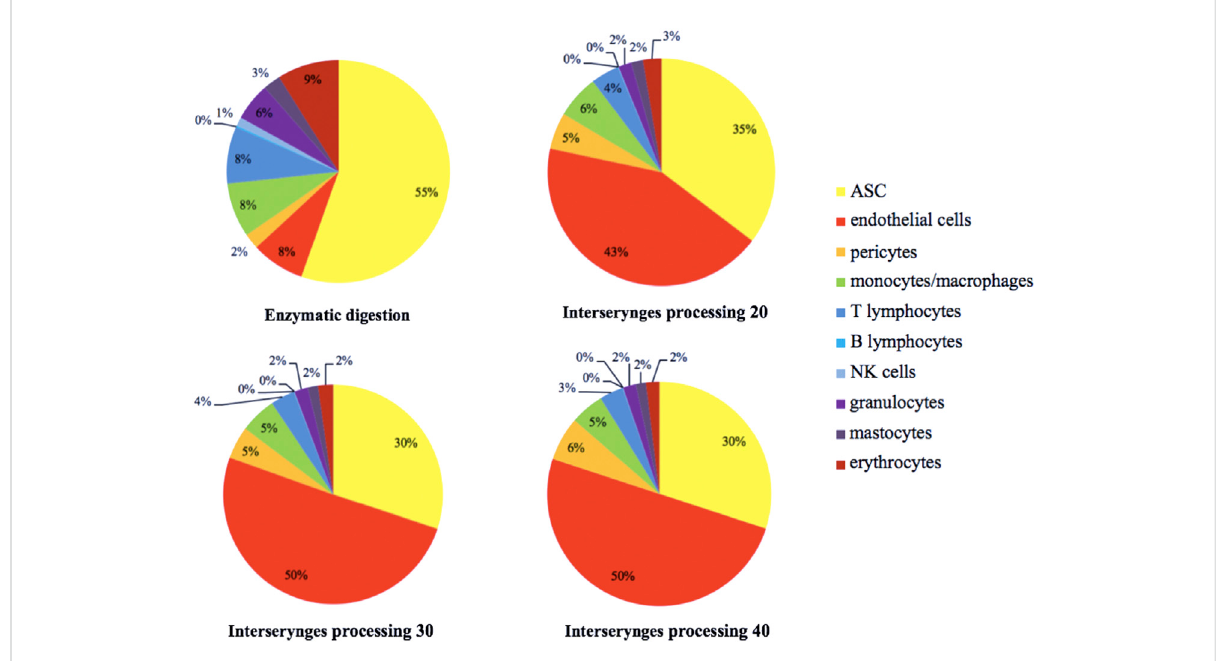
FIGURE 4 Estimated distribution of the different SVF cell populations, distributed according to the color code indicated. The percentage represents the proportion of each cellular sub-population. SVF: stromal vascular